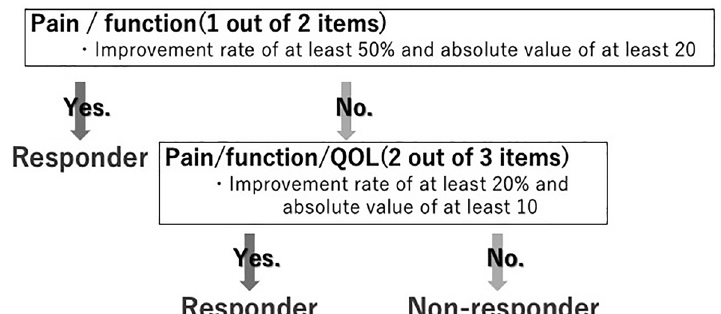
Figure 1. The Outcome Measures in Arthritis Clinical Trials–Osteoarthritis Research Society International (OMERACT–OARSI) criteria 10 .